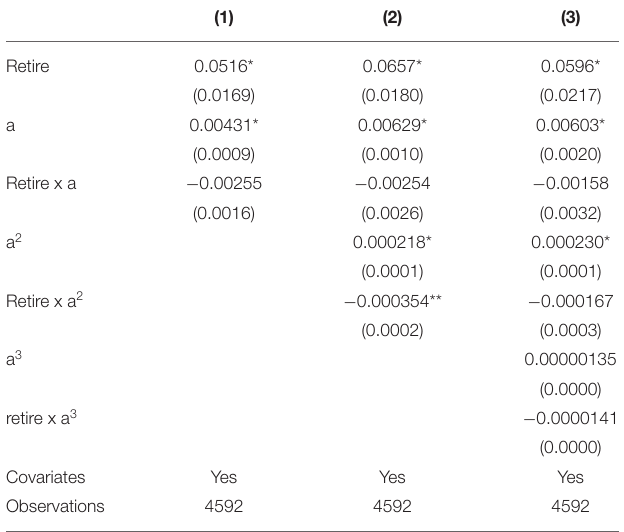
TABLE 10 | Analysis of the impact of retirement on the happiness of different